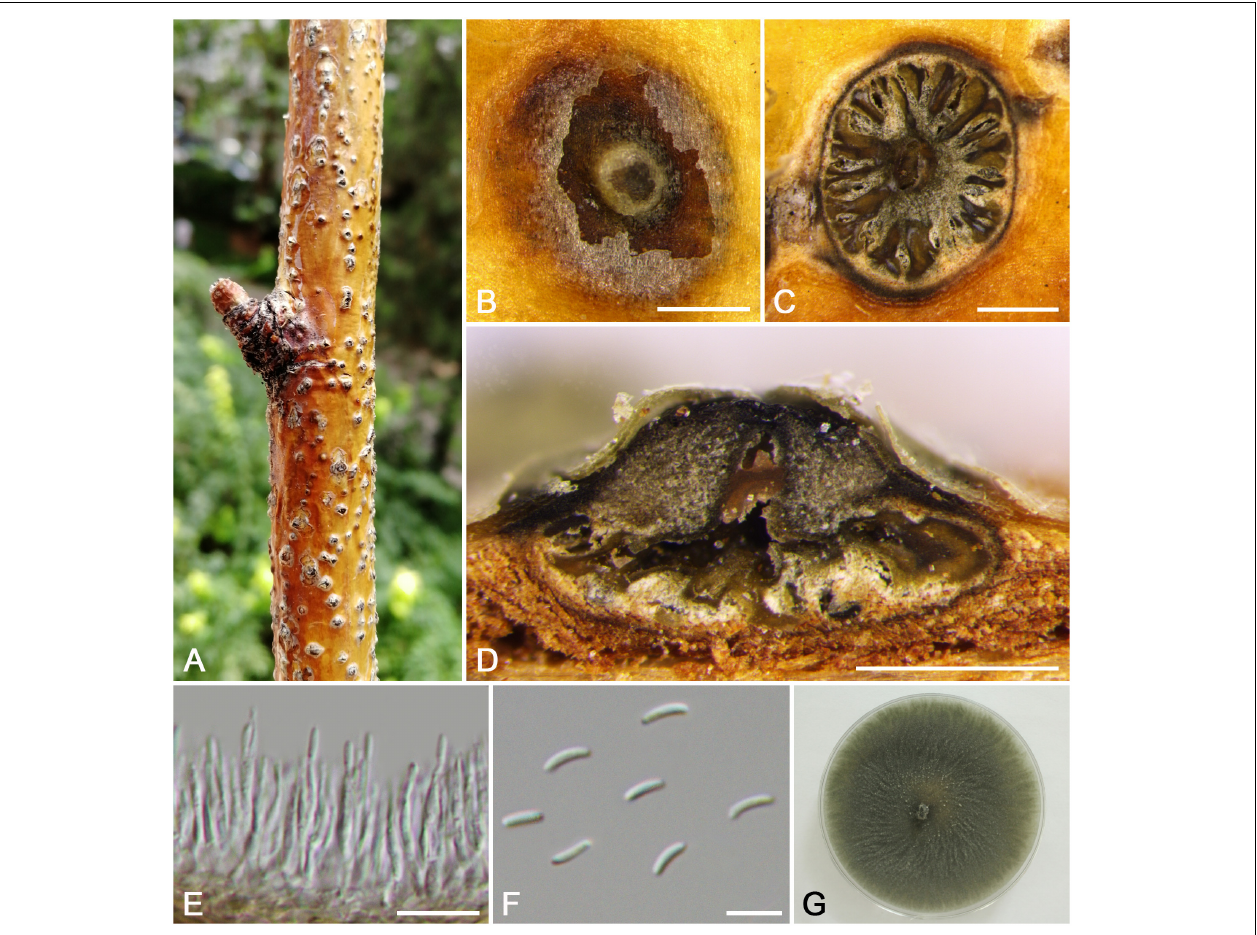
FIGURE 8 | Morphology of Cytospora olivacea from Sorbus tianschanica (CF 20197670). (A,B) Habit of conidiomata on twig. (C) Transverse section of conidioma. (D) Longitudinal section through conidioma. (E) Conidiophores and conidiogenous cells. (F) Conidia. (G) Colonies on PDA for 2 weeks. Bars: (B–D) = 500 µ m; (E) = 10 µ m; (F) = 5 µ